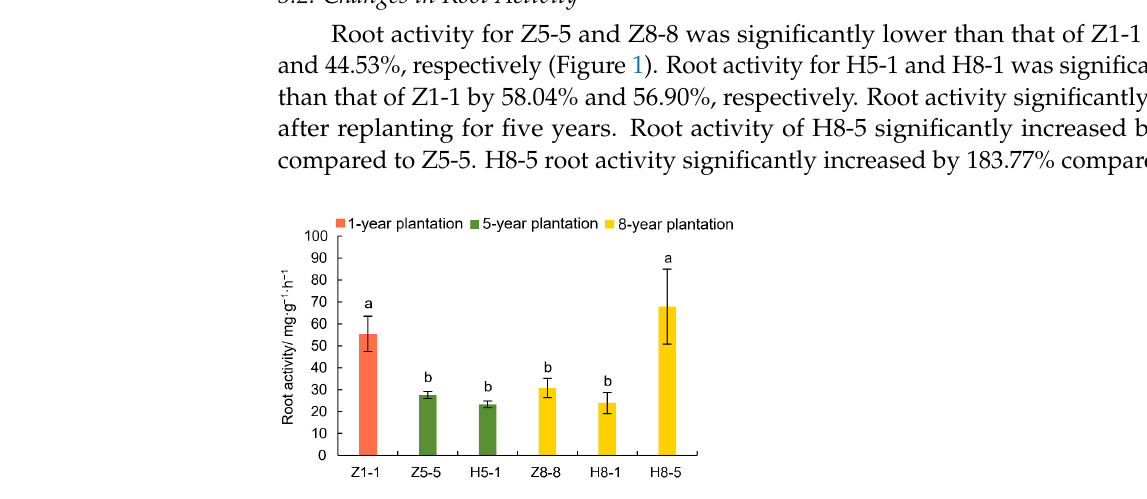
Figure 1. Root activity of herbaceous peony in different growing and replanting years. Note: Sample nomenclature is the same as Table 1. Different lowercase letters indicate significant differences at p < 0.05.